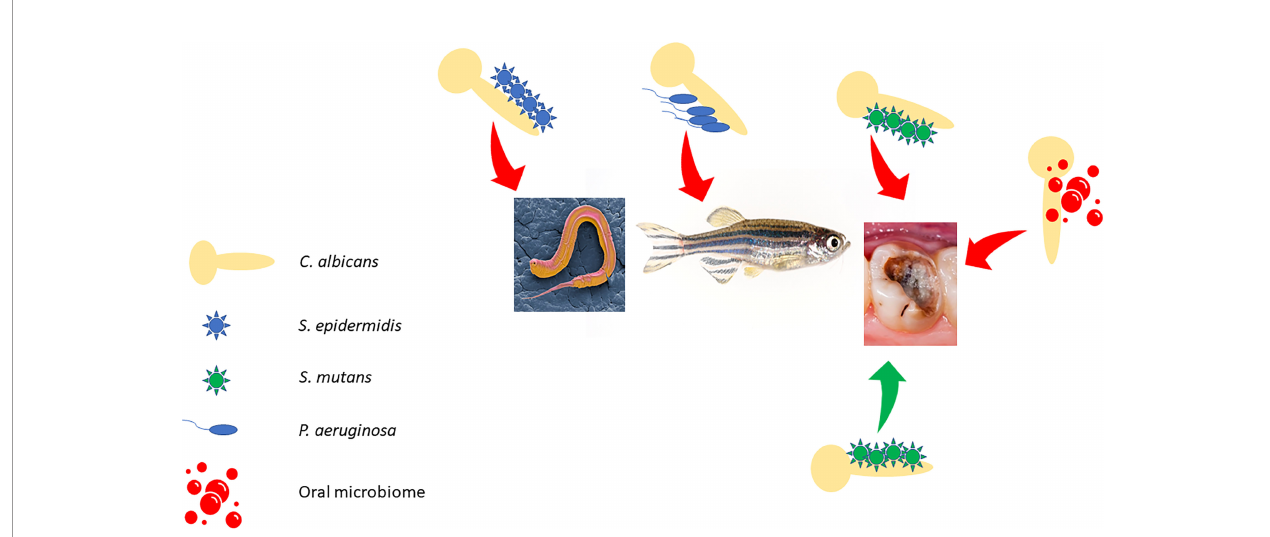
FIGURE 2 | Outcome of polymicrobial bio fi lm infections in different hosts/host niches. Red arrows indicate increased pathogenicity, and the green arrow indicates decreased pathogenicity as discussed in the